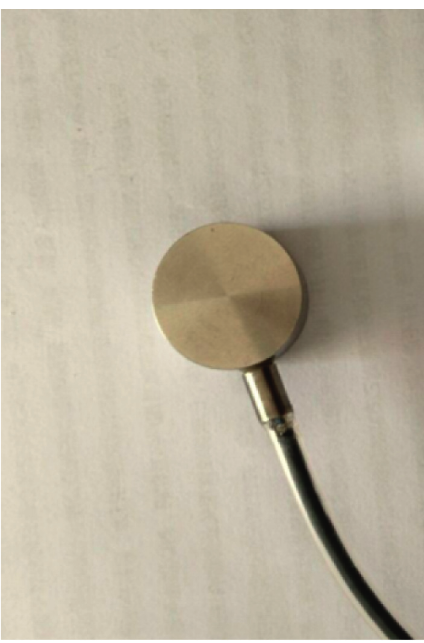
Figure 4: Photo of miniature silicon piezoresistive Earth pressure sensor. Table. 1: Performance indexes of miniature silicon piezoresistive pressure